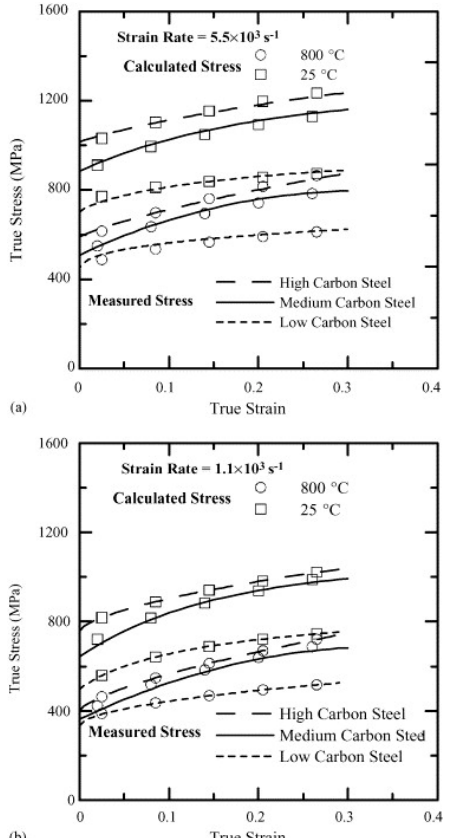
Figure 35. Comparison of calculated and experimental flow curves at two different conditions at ( a ) 5.5 × 10 − 3 s − 1 and ( b ) 1.1 × 10 − 3 s − 1 Table 2. Calculated values of Zerilli–Armstrong coefficients [123] .